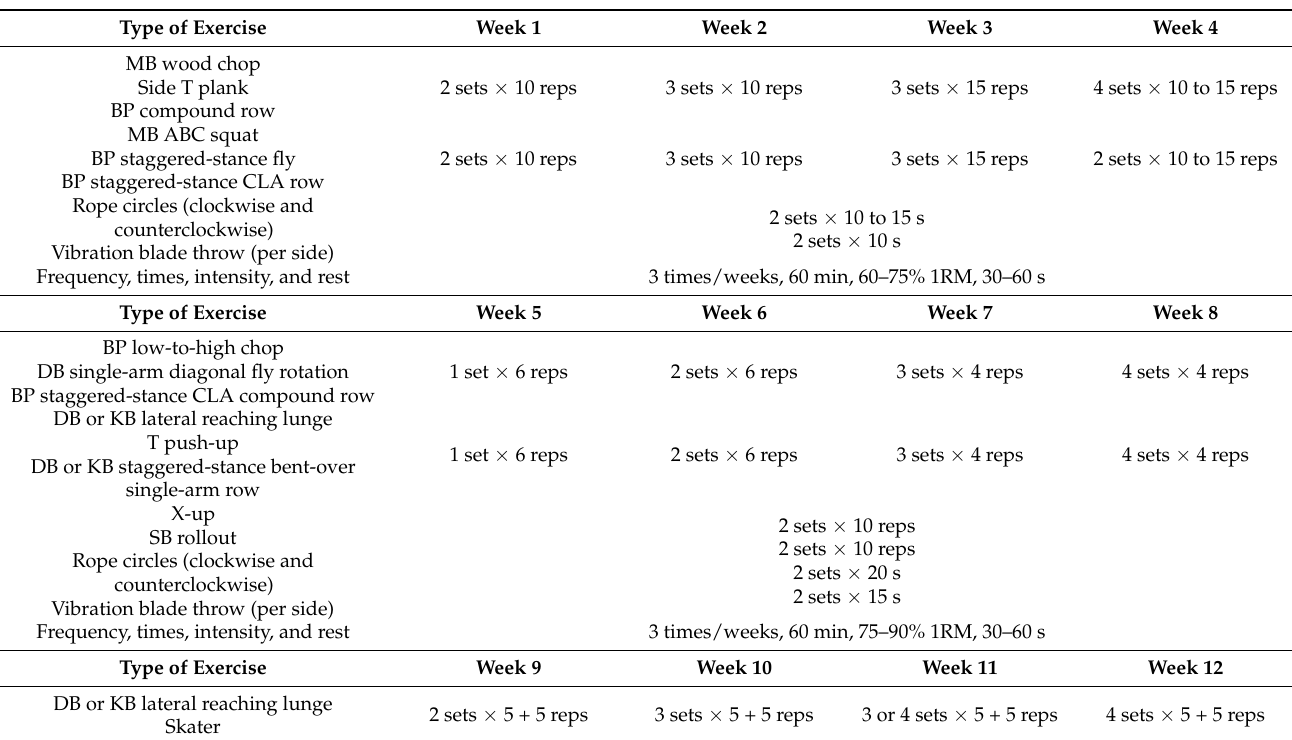
Table 2. A detailed description of the 12-week functional